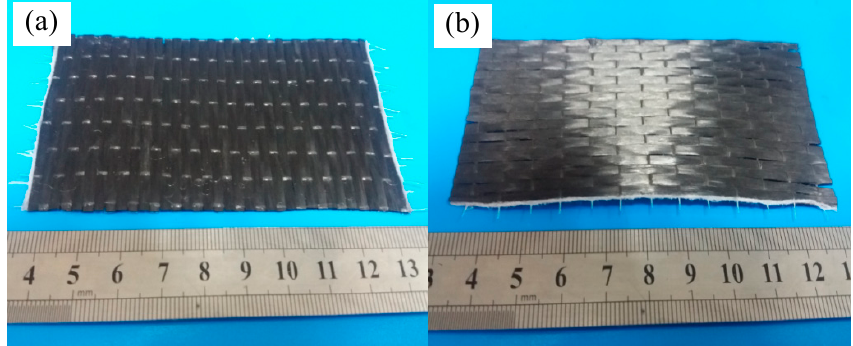
Figure 1. Cutting T700 carbon fiber cloth sheets with the two fiber directions. ( a ) Length direction is perpendicular to the fiber axis; ( b )The length direction is parallel to the fiber axis. Table 1. Process parameters of improved compression molding (ICM) for preparing 2D-T700/E44 composites.